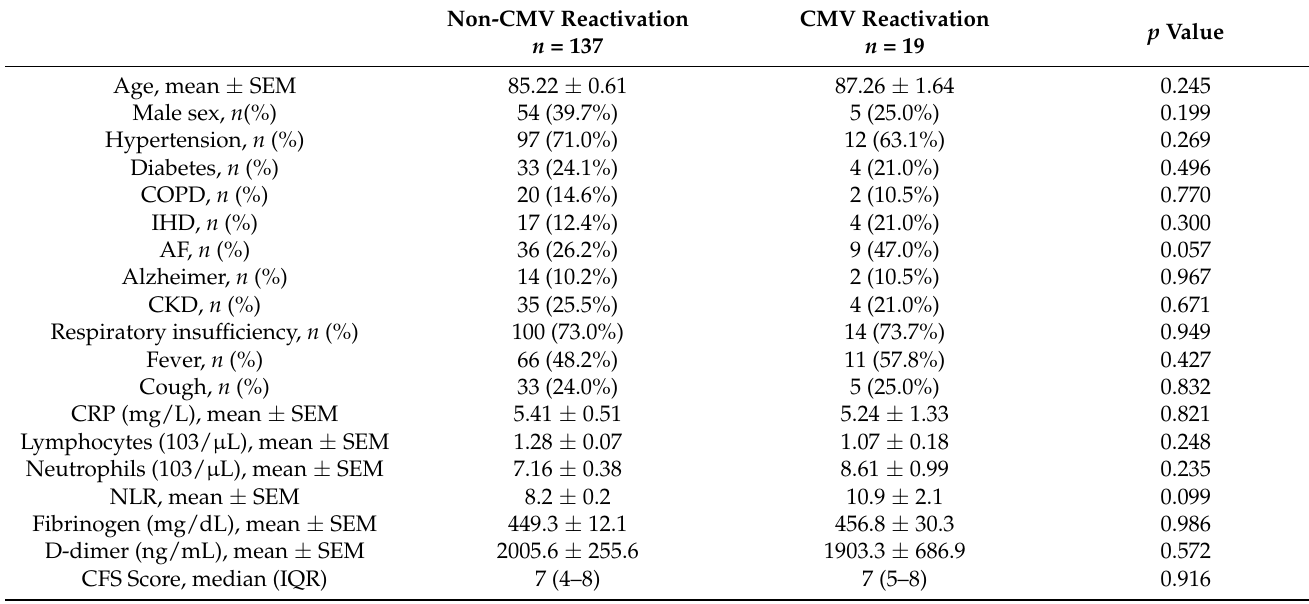
Table 1. Baseline clinical patient characteristics.